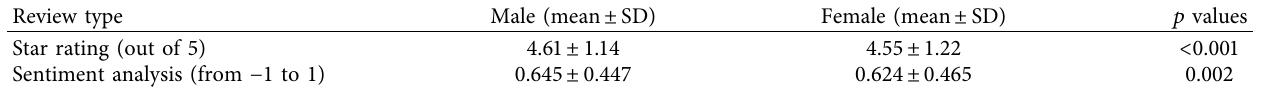
Table 2: Gender analysis based on star rating and review sentiment analysis.